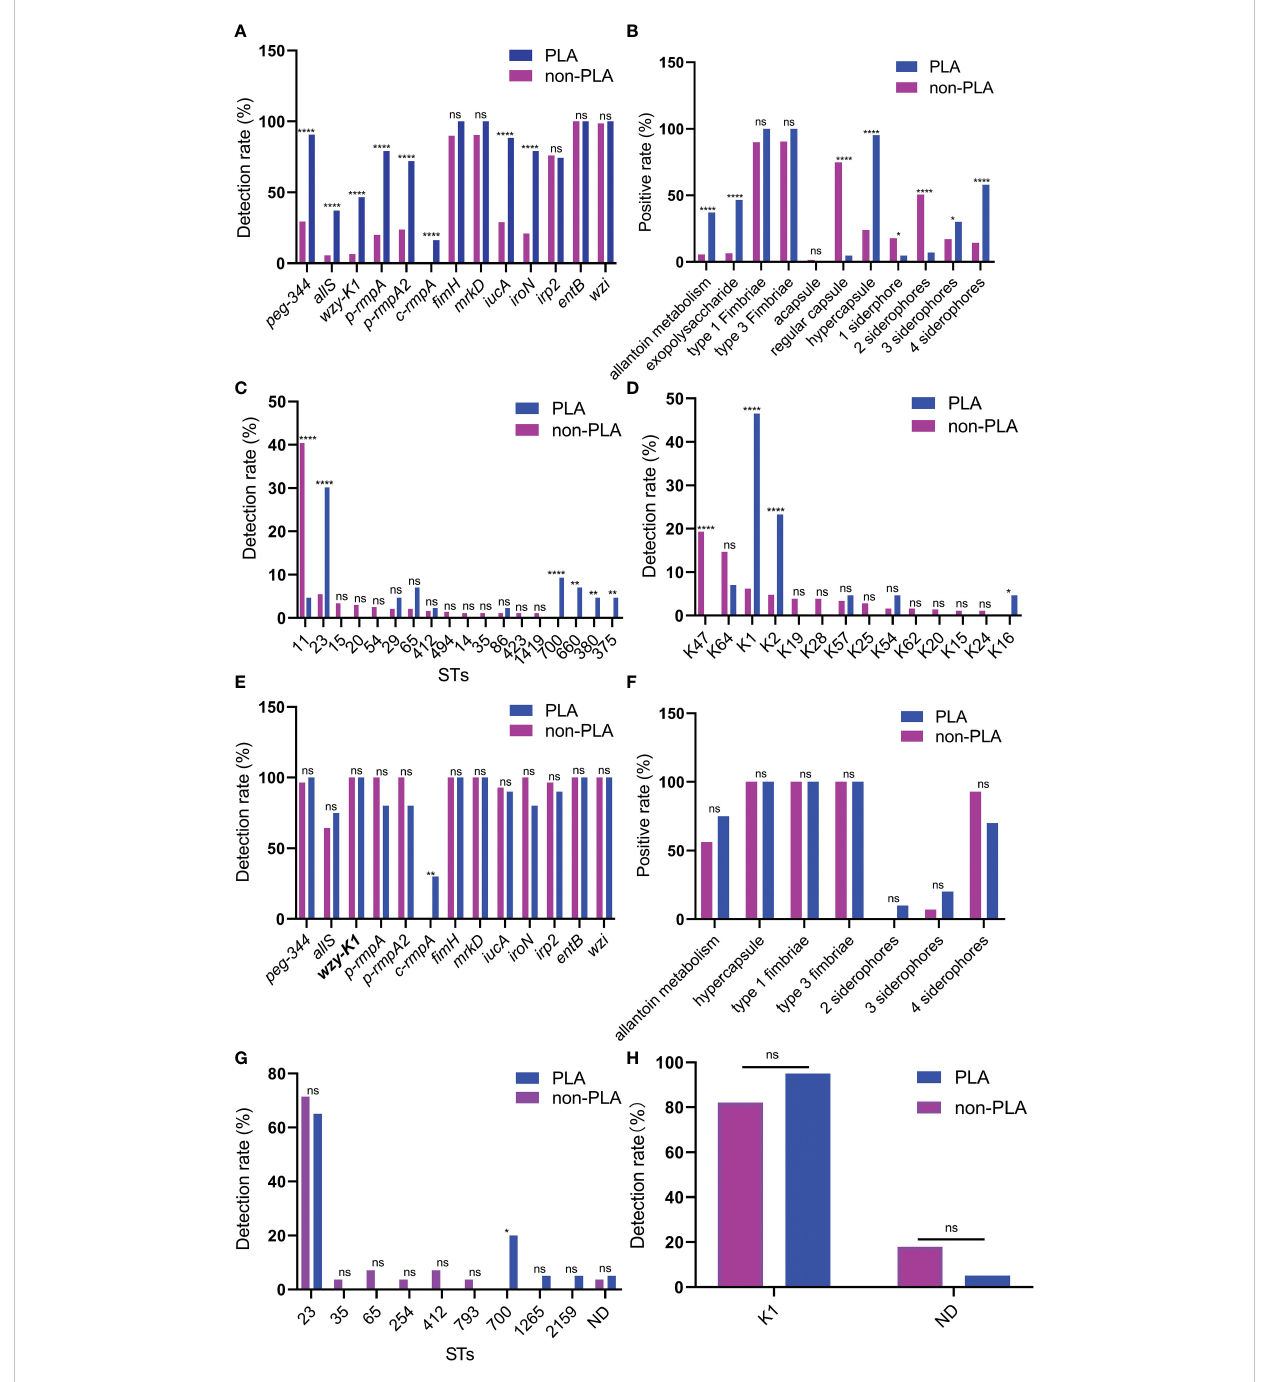
FIGURE 1 Differences between Klebsiella pneumoniae from PLA and non-PLA samples. (A) Differences in virulence genes; (B) Differences in virulence factors; (C) Differences in STs; (D) Differences in serotypes; (E) Differences in virulence genes when wzy-K1 is positive; (F) Differences in virulence factors when wzy-K1 is positive; (G) Differences in STs when wzy-K1 is positive; (H) Differences in serotypes when wzy-K1 is positive. PLA: pyogenic liver abscess; PLA group: n = 43 (A – D) n = 20 (E – H) non-PLA group: n = 436 (A – D) n = 28 (E – H) ns: not signi fi cant; * p < 0.05; ** p < 0.01; **** p < 0.0001; ST, sequence type; ND, not de fi ned. Chi-square tests and Fisher ’ s exact tests were used to compare the positive rates between PLA and non-PLA